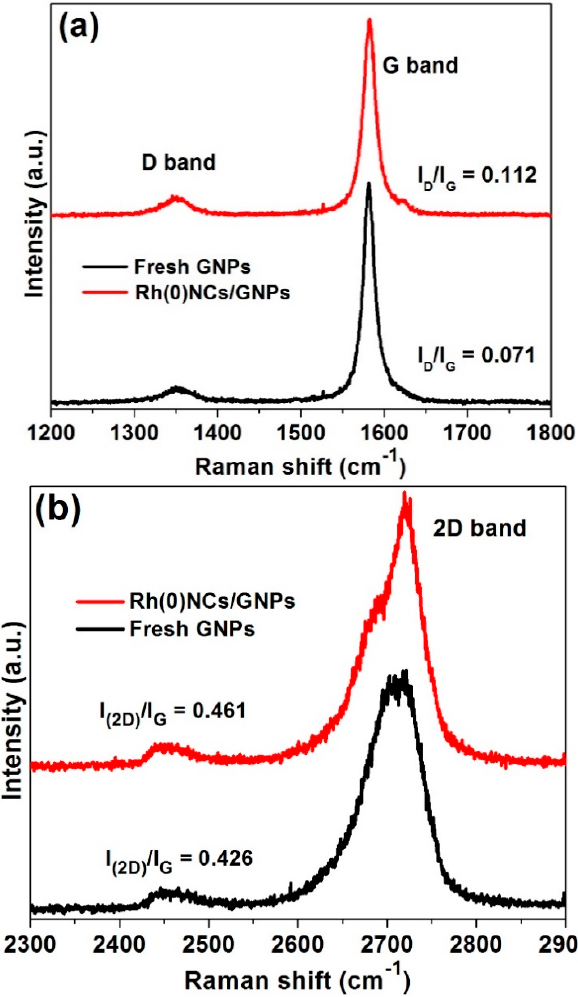
Figure 4. Raman spectra of fresh GNPs and Rh(0)NCs / GNPs, ( a ) D + G band, ( b ) 2D